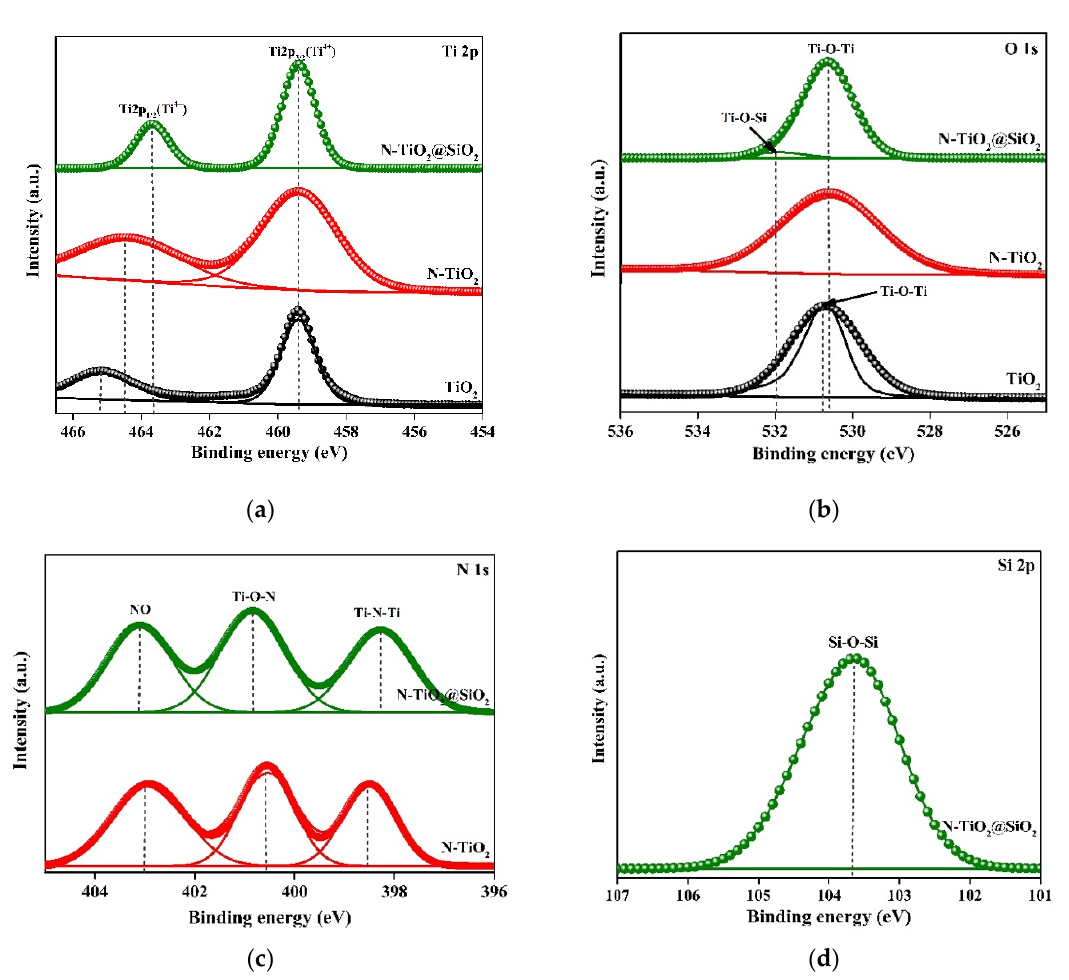
Figure 3. The XPS spectra of TiO 2 , N-TiO 2 , and N-TiO 2 @SiO 2 core / shell for ( a ) Ti 2p, ( b ) O 1s, ( c ) N 1s, and ( d ) Si 2p.